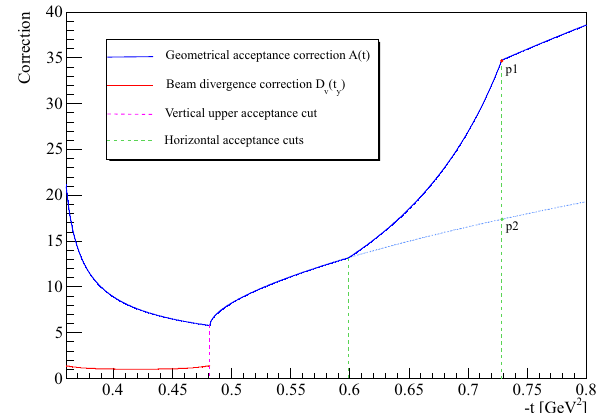
Fig. 7 The pp differential elastic cross section d σ/ d t of DS1 at